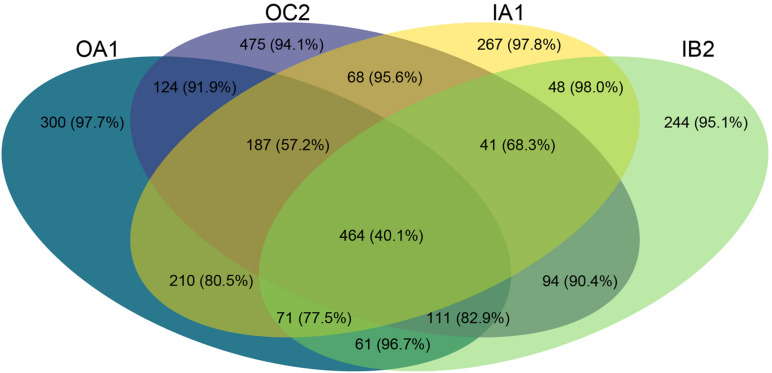
Venn diagram depicting the number of shared ASVs per poultry house across all timepoints. In parentheses, the percentage of these ASVs which are rare (relative abundance of < 0.01%) are shown.